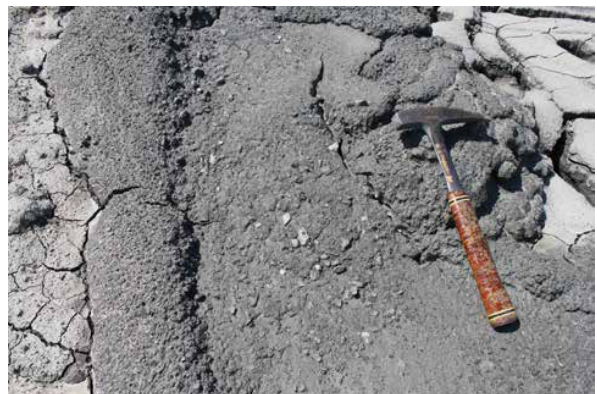
654 Fig. 4. Fresh mud flow erupted at Puianello shortly after the 20 Figure 4: Fresh mud flow erupted at Puianello shortly after the 20 May, 2012 655 May 2012 earthquake (photo taken 24 May 2012). The mud flow earthquake (photo taken 24 May, 2012). The mud flow contains several ~2 cm 656 clasts. During sampling in January 2011 no large clasts were being transported to 657 contains several ∼ 2cm clasts. During sampling in January 2011, the surface. 658 no large clasts were being transported to the